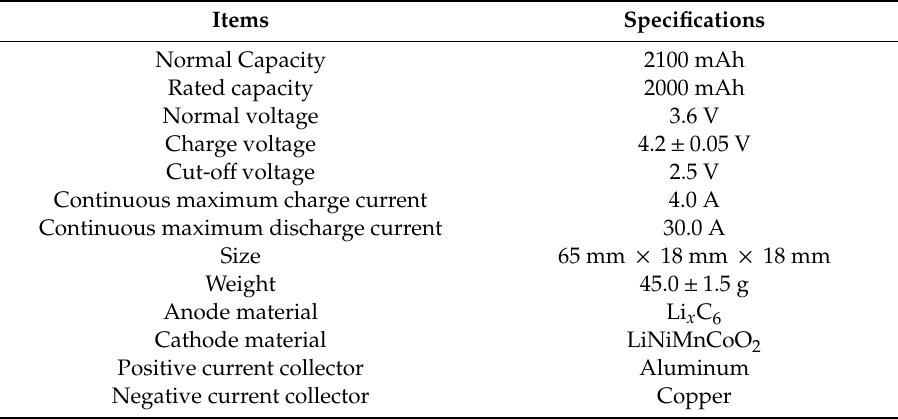
Table 1. Specifications of 18650